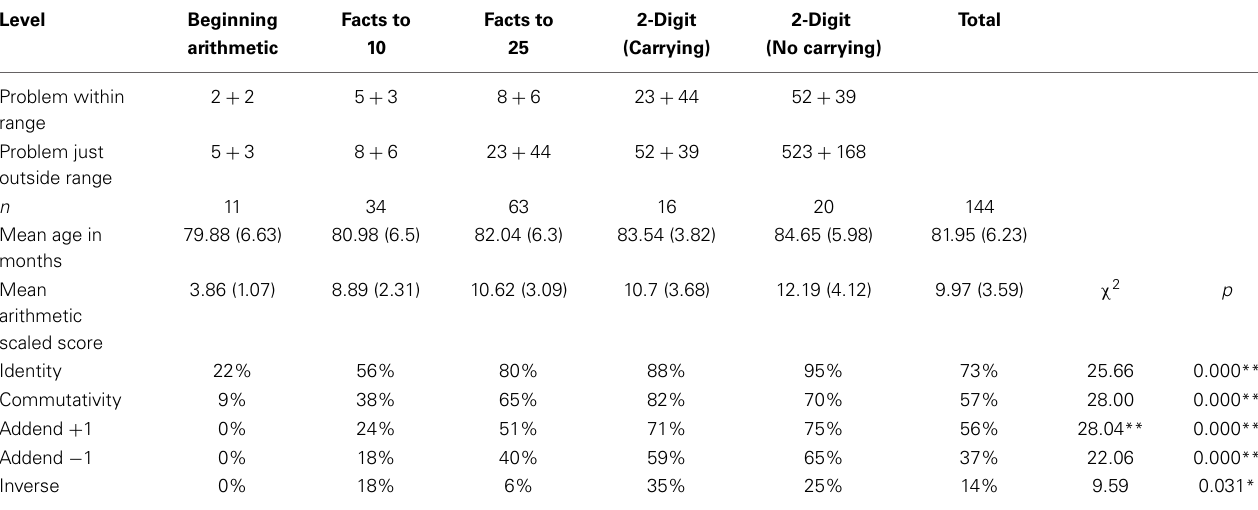
Table 1 | Addition strategies used at different